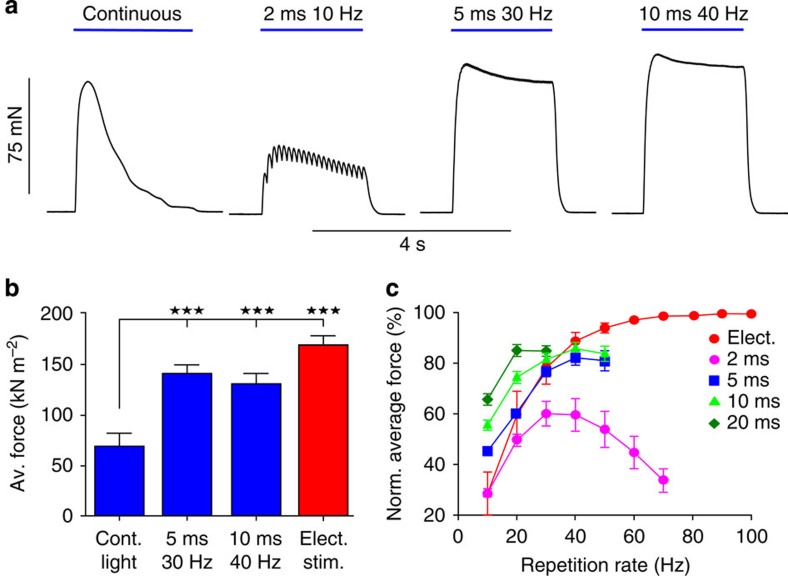
Optogenetic generation of tetanic contractions.(a) Representative examples of sustained contractions generated by various 2-s-long illumination patterns. (b) Quantification of average force during optical stimulation in comparison with electrical stimulation (100 Hz, 20 V, 1 ms, biphasic) (P<0.0001, repeated Dunnett ANOVA test with continuous light stimulation as control, n=6). (c) Relationship between repetition rate and average force normalized to maximal electrical stimulation for different light pulse durations (n=4). Error bars, s.e.m. Av., average; cont., continuous; elect., electrical; norm., normalized; stim., stimulation.